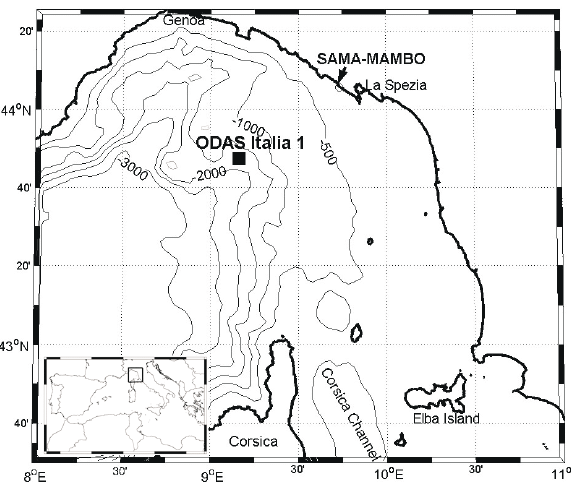
Fig. 1. Map of the Ligurian Sea showing the location of the ODAS Italia 1